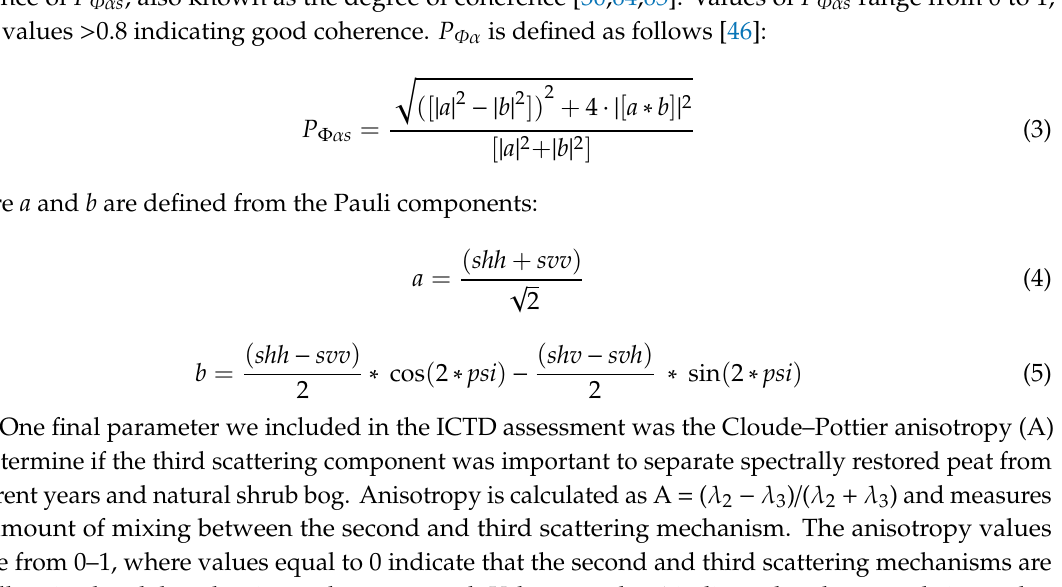
Figure 2. PCI Geomatica Processing chain used to process the FD and the ICTD. The final step was to